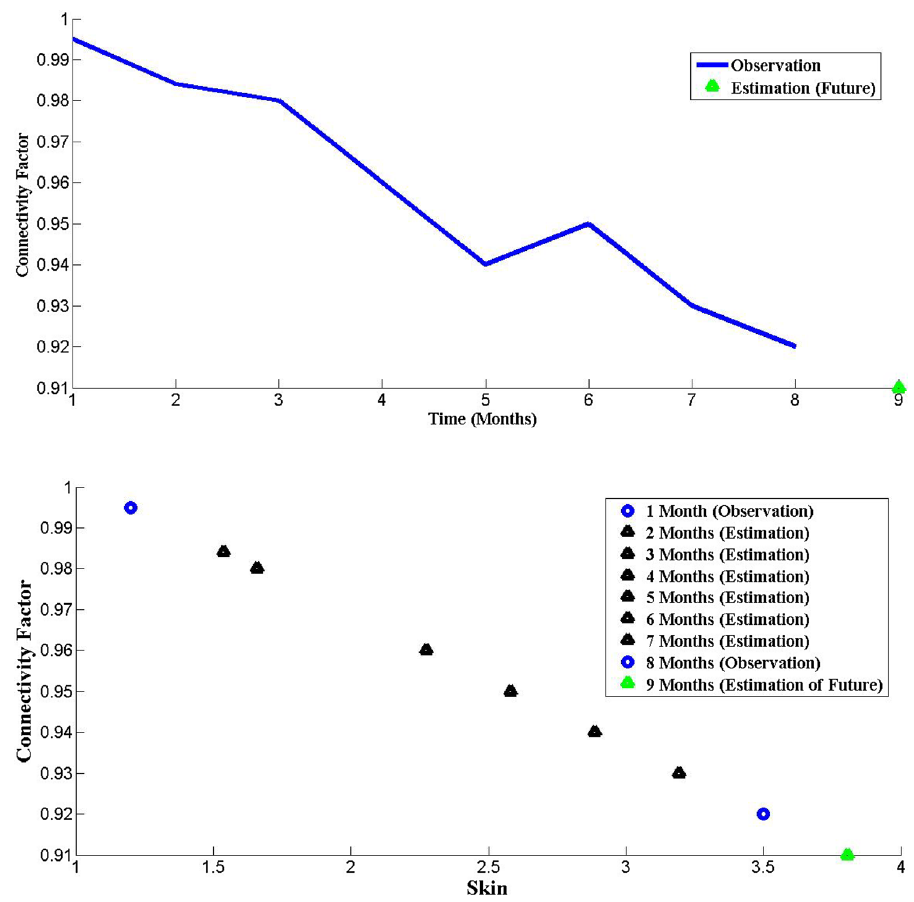
Fig. 13 Connectivity factor for the damaged injector in the real case